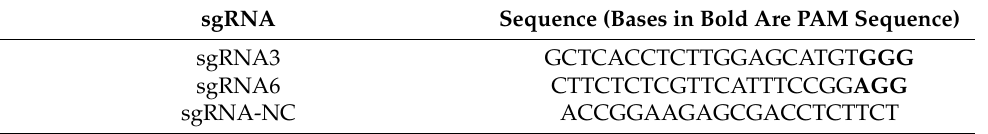
Table 1. sgRNA sequences target to mouse Scd1